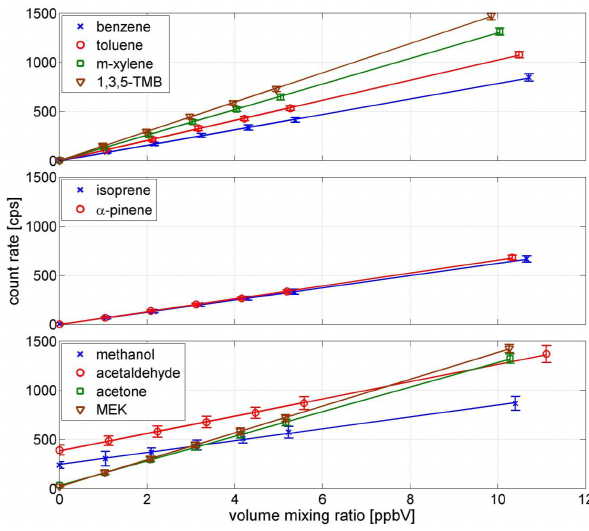
Figure 3. Calibration curves for aromatic VOCs (top), biogenic VOCs (center), and oxygenated VOCs (bottom). Measured signals are ion count rates at m/z’s of the protonated molecules. Error-bars indicate the precision of the 1 Hz data.